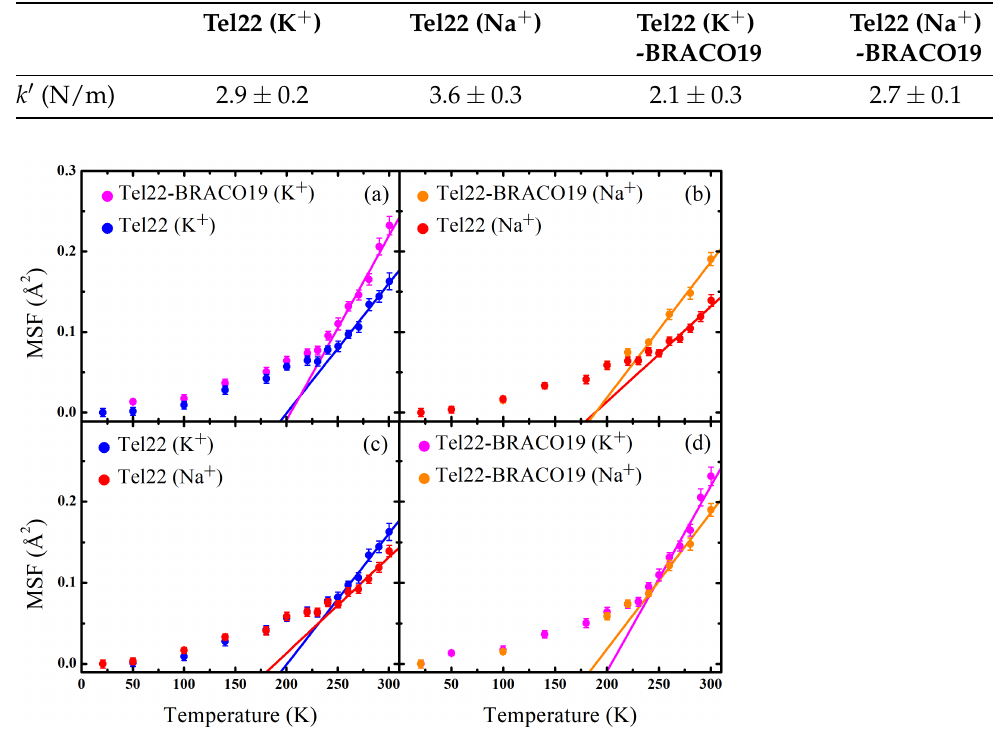
Table 1. Force constants as extracted from the best fit to the data using Equation (4).